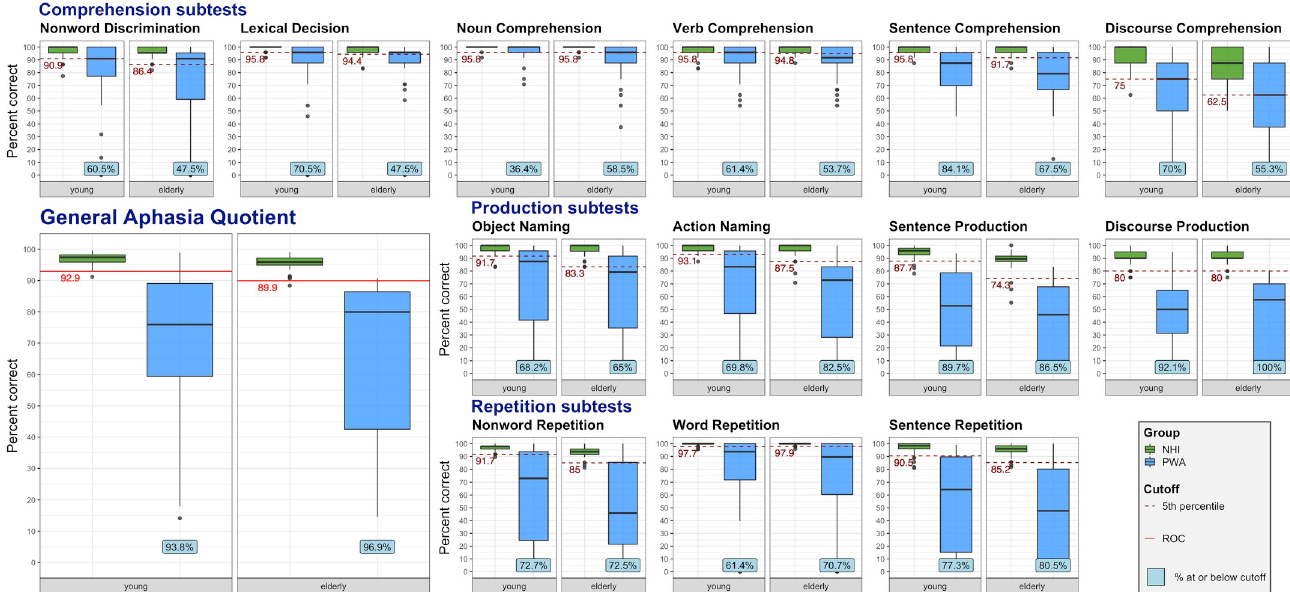
Fig 1. Accuracy subtest scores and the General Aphasia Quotient (GAQ) for the control group of neurologically healthy individuals (NHI) and the main group of people with aphasia (PWA) for each age cohort. The box represents the interquartile range, with the central line marking the median. The whiskers denote the largest/smallest values within 1.5 times the interquartile range above/below the 75 th /25 th percentile. Values falling outside of that range are shown as black points. Red lines indicate cutoff thresholds: dashed for each subtest, representing the 5 th percentile of the control group, and solid for the GAQ cutoff, determined according to Receiver Operating Characteristic (ROC) curve analysis. The cyan box with percentages represents percent of PWA performing in the impaired range (at or below cutoff for normal performance for a given subtest).